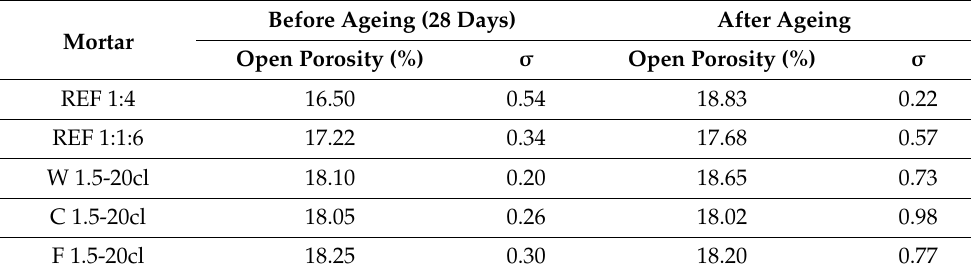
Table 4. Open porosity of the mortars applied on a brick.